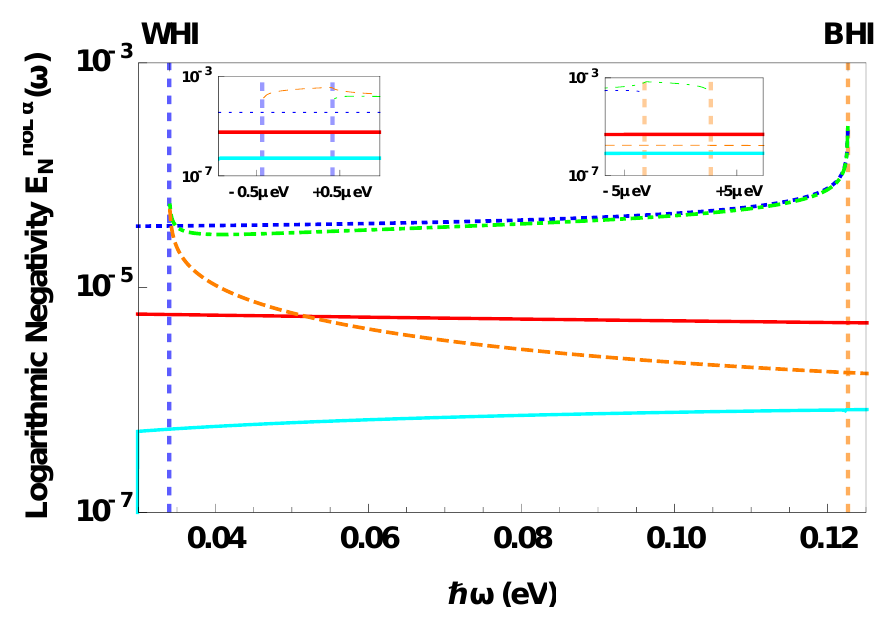
Figure 4: Entanglement of noL with the positive norm modes. lL , turquoise solid line; loL , orange dashed line; moR , green dot-dashed line; uoL , blue dotted line; uL , red solide line. Insets zoomed-in around the center frequency of the WHI and BHI. α a positive norm